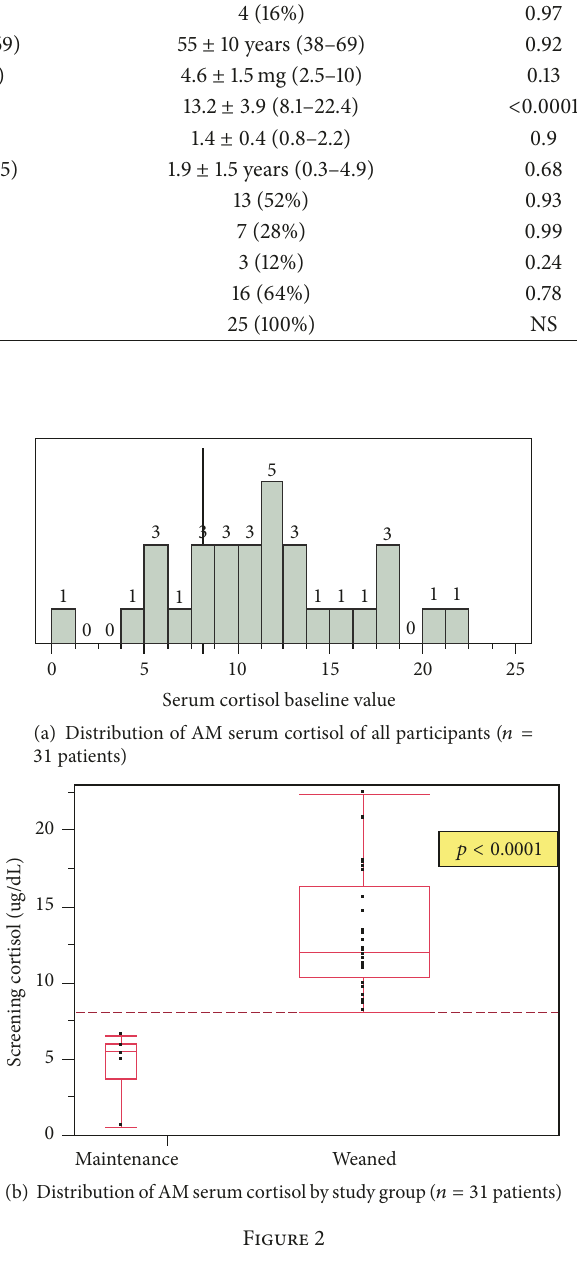
depicted. Figure 3(b) shows survival beginning on the day of study consent, ending in death or July 2017 which represents approximately 10 years of follow-up. The survival of the steroid-weaning group was not significantly different from that of the corticosteroid maintenance group, but the analysis is hampered by a small sample size (grossly underpowered for